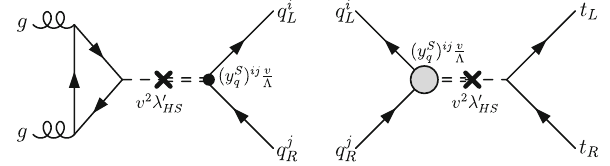
Fig. 10 Resonant contributions of the mediator to di-jet and t ¯ t final states, turning on the interactions ∼ λ (cid:3) and ∼ ( y S q ) ij . Replacing the HS latter by c S or ( y S (cid:8) ) ij leads to further interesting contributions to W , B , G di-boson, di-jet, and di-lepton final